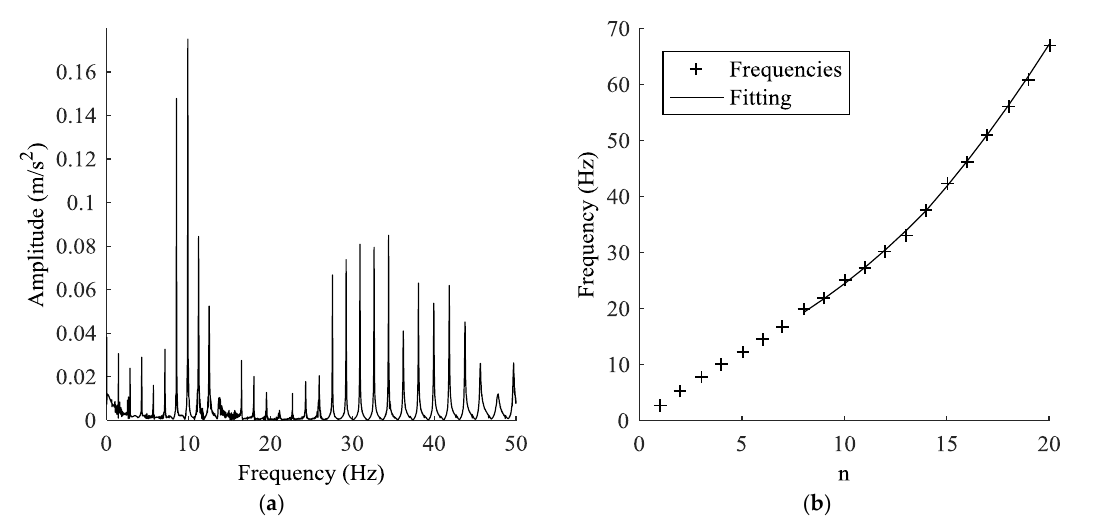
Figure 7. ( a ) Fast Fourier transform of the signal acquired on the cable 1TN and ( b ) comparison between the measured frequencies (points) and the theoretical trend (continuous line). Table 2. First 16 frequencies in Hz obtained with FFT.